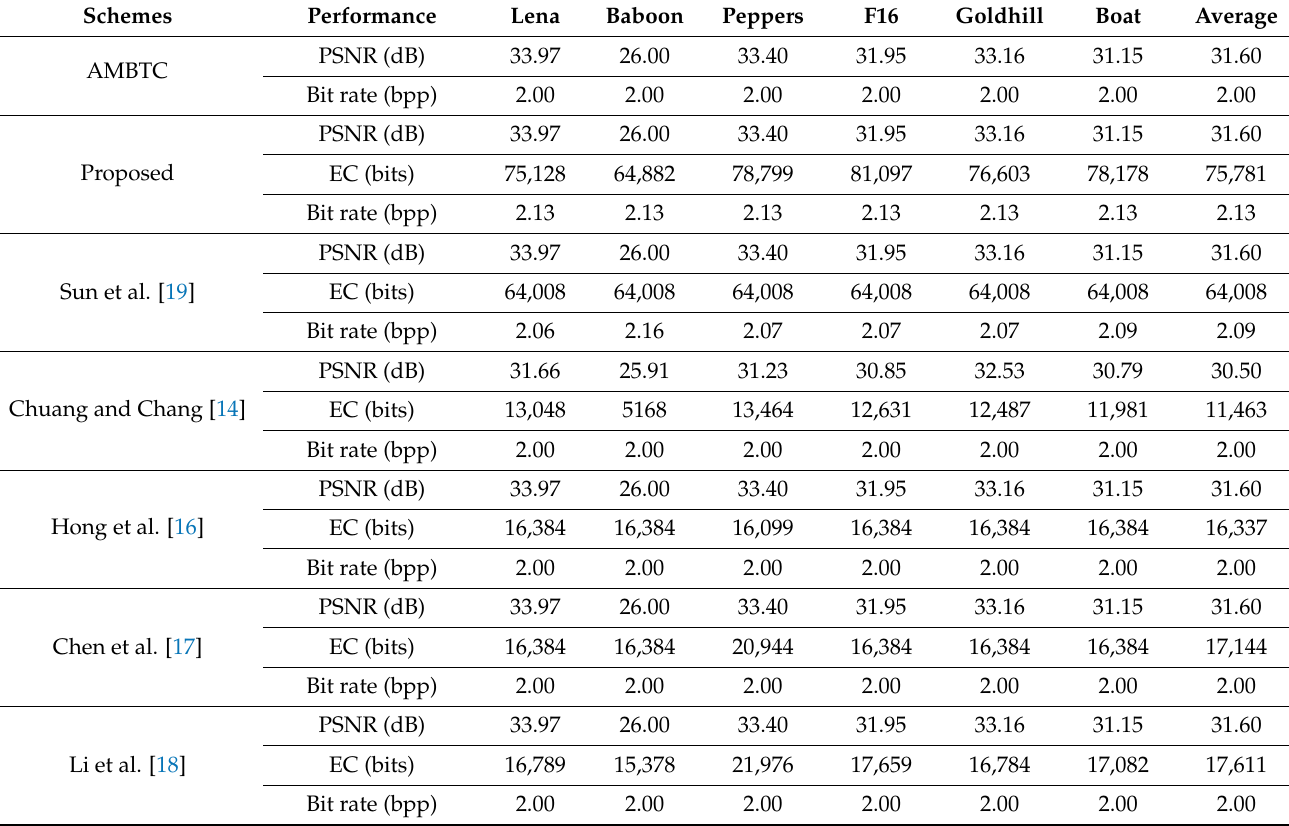
Table 2. Performance comparison of the proposed scheme and seven previous schemes